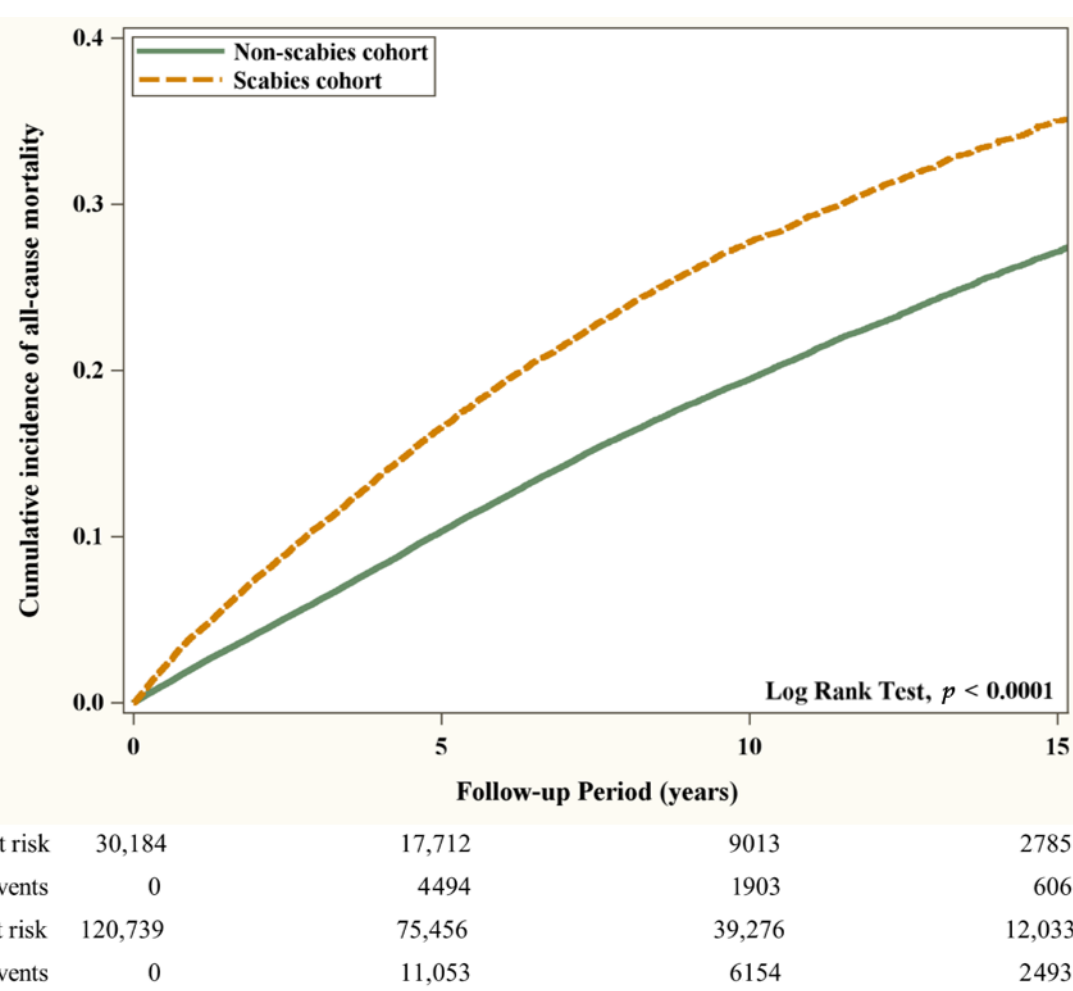
Figure 3. Cumulative risk of all-cause mortality in patients with and without scabies.